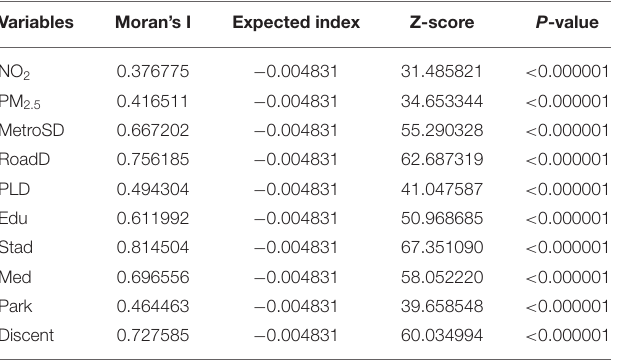
institution POIs, the percentage of park POIs, and the straight- line distance from the city